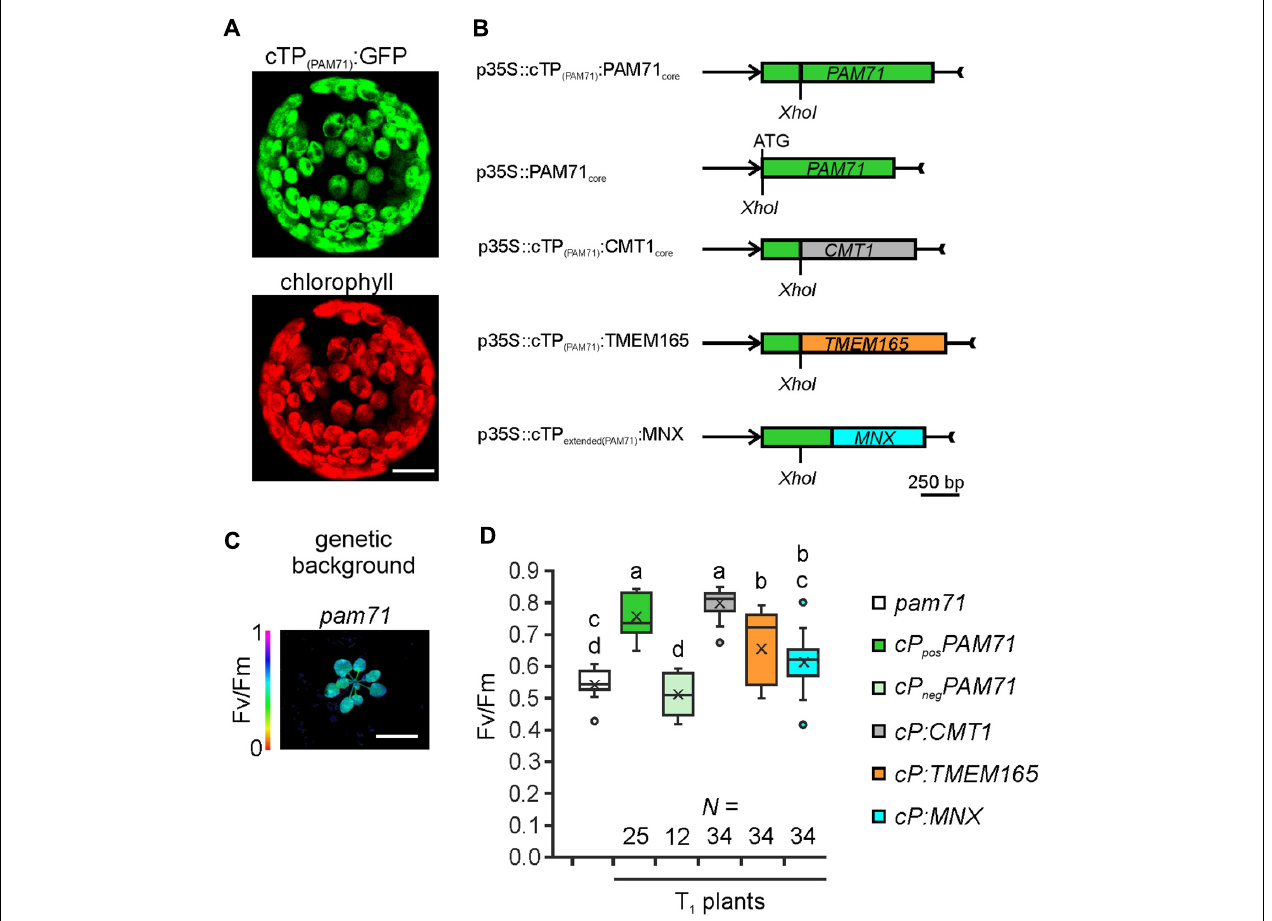
FIGURE 3 | Experimental setup for gene replacement assays. (A) Verification of the N-terminal PAM71 sequence as a chloroplast-targeting peptide. Nicotiana benthamiana leaves were infiltrated with the Agrobacterium strain containing p35S:cTP ( PAM 71 ) :GFP; protoplasts were isolated after 48 h and analyzed by confocal microscopy. Scale bar = 12.5 µ m. (B) Scheme depicting the chimeric constructs used for transformation of pam71. (C) The pam71 mutant as genetic background. The maximum quantum yield of PSII (Fv/Fm) of a 4-week-old plant is shown. Scale bar = 1 cm. (D) Photosynthetic activity of BASTA-resistant T 1 transgenic plants in comparison to pam71 . The maximum quantum yields of PSII (Fv/Fm) of T 1 plants are depicted as box plots representing the range of values, the exclusive median and the mean, indicated as x. The number of independent individuals is given ( N ). Outliers are indicated as dots. Different letters indicate statistical significance based on ANOVA ( p < 0.01, Tukey’s honestly significant difference (HSD)